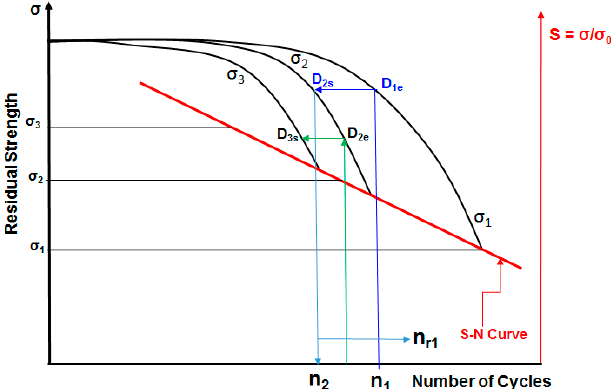
Figure 5. A schematic showing the cumulative damage approach.